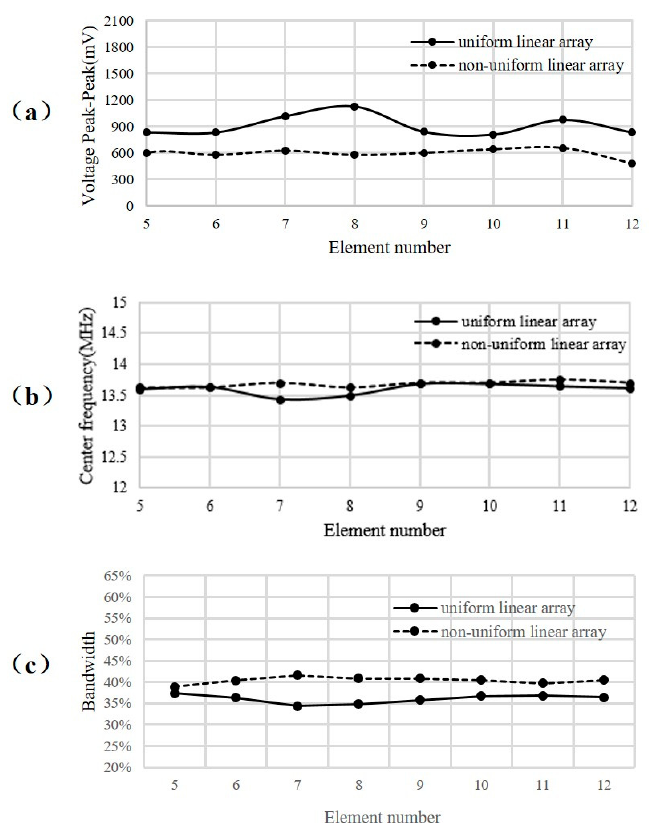
Figure 14. Comparisons of peak-to-peak voltage and center frequency between the MULA and the MNULA. ( a ) Peak-to-peak voltage, ( b ) center frequency, and ( c ) bandwidth at − 6 dB.